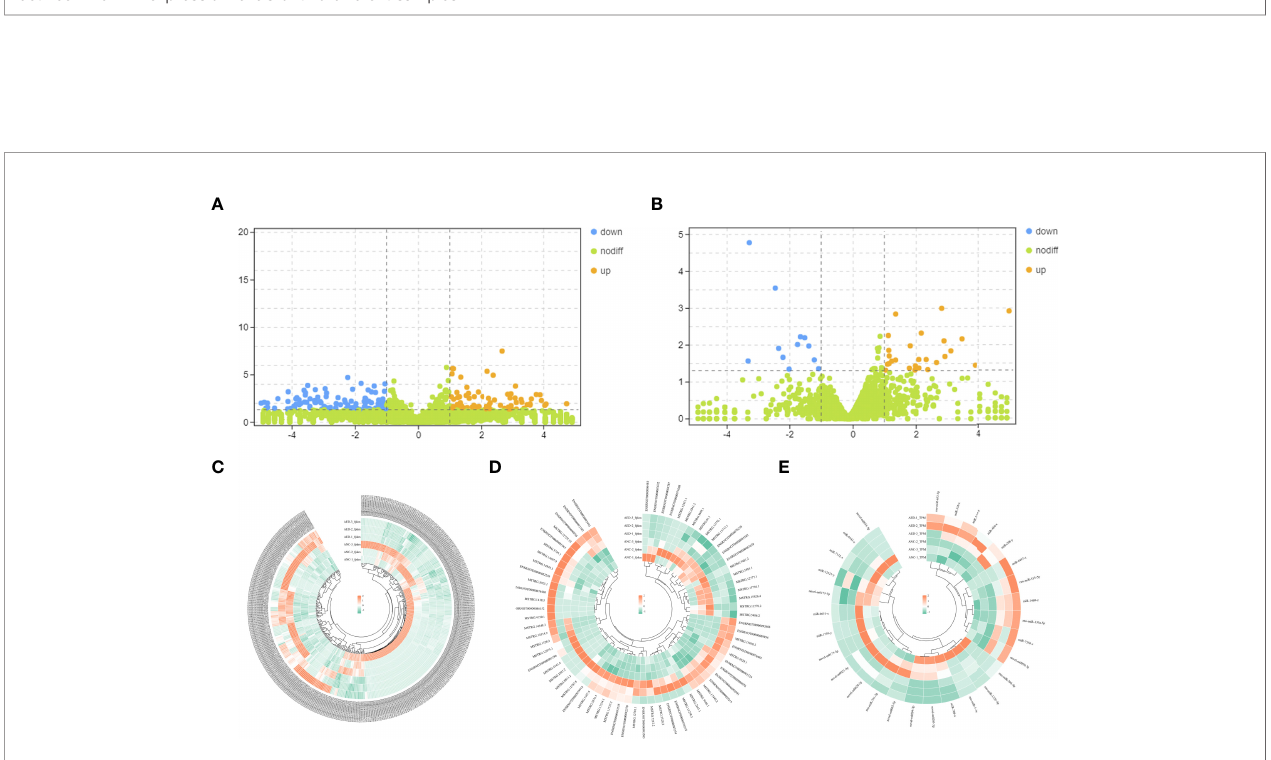
FIGURE 2 | Data distribution and quality assessment. (A) A violin diagram of the FPKM value of all mRNAs within each sample. (B) A violin diagram of the FPKM value of all lncRNAs within each sample. (C) Scatter plot of correlation between mRNAs expression levels in two different samples. (D) Scatter plot of correlation between lncRNA expression levels of two different samples.